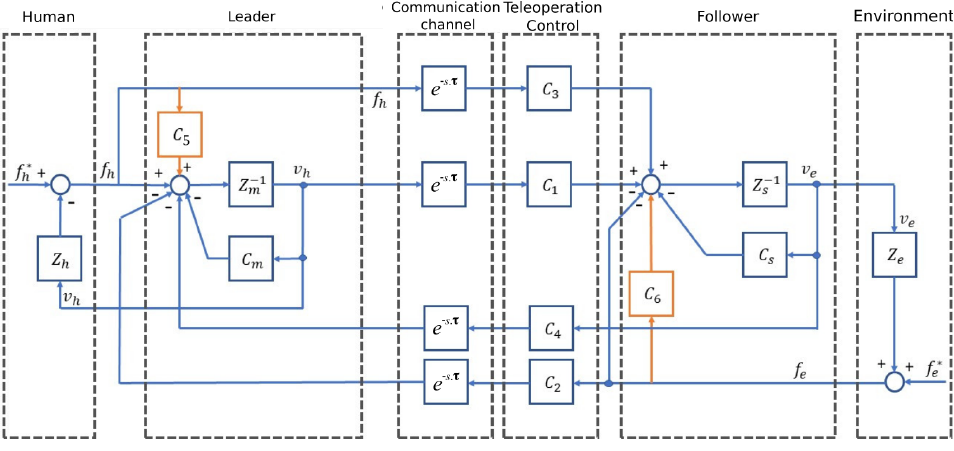
Figure 1. Lawrence’s four-channel teleoperation (which becomes E-LFC when C 5 , C 6 (cid:54) = 0). One of the main challenges of haptics-enabled telerobotic systems is the communica- tion delay. It can be mathematically shown that the delay would inject extra energy into the system resulting in accumulation of energy in the closed loop system which can (under some circumstances) result in instability and divergence. There has been a wide range of research and development activities to design and implement various stability frameworks for robotic and haptic systems to deal with the instability caused by the delay. Most of the existing approaches function based on Weak Passivity Control Theory (W-PCT). For this, the environment and the operator are usually considered to be passive, while the commu- nication network is considered to be the source of nonpassivity due to the communication delays. Based on W-PCT, by making the communication passive, a telerobotic system will be converted to a negative interconnection of passive subsystems (Human, Communication, Environment), which will be passive and thus stable. The existing approaches usually provide local (on one side) or distributed (on two sides of the communication) damping to dissipate the extra energy introduced into the system by a nonpassive interconnection link and guarantee global passivity and thus stability. In this regard, the wave variable transformation (WVT) rooted in scattering transformation (ST) is the most commonly used approach in the literature [82] (see Figure 2). Using WVT, the transmitted force and motion signals are converted to wave variables. It has been shown that in the presence of unknown constant communication delay, WVT results in the passivity of the network. An important feature of WVT is that the transformation at the leader side is the inverse of transformation at the follower side. As a result, in the absence of communication delay (which would result in the passivity of the communication), the two transformations would cancel out each other, and thus no signal deviation would be imposed. However, in the presence of communication delays, the two transformations cannot completely cancel out each other, and this would result in a deviation of force and velocity tracking. WVT utilizes a tuning factor named wave impedance, which distributes the deviation from the reference between the force and velocity channels. A major problem with WVT is the sensitivity to variable time delays. Various versions of the WVT have been proposed in the literature (see [83] for a 2014 review), some of which are to make it robust to variability in the time delay, for example, using wave scaling, the intensity of which depends on the variability of time delay (the higher the variability, the lower the scale). Although the problem has